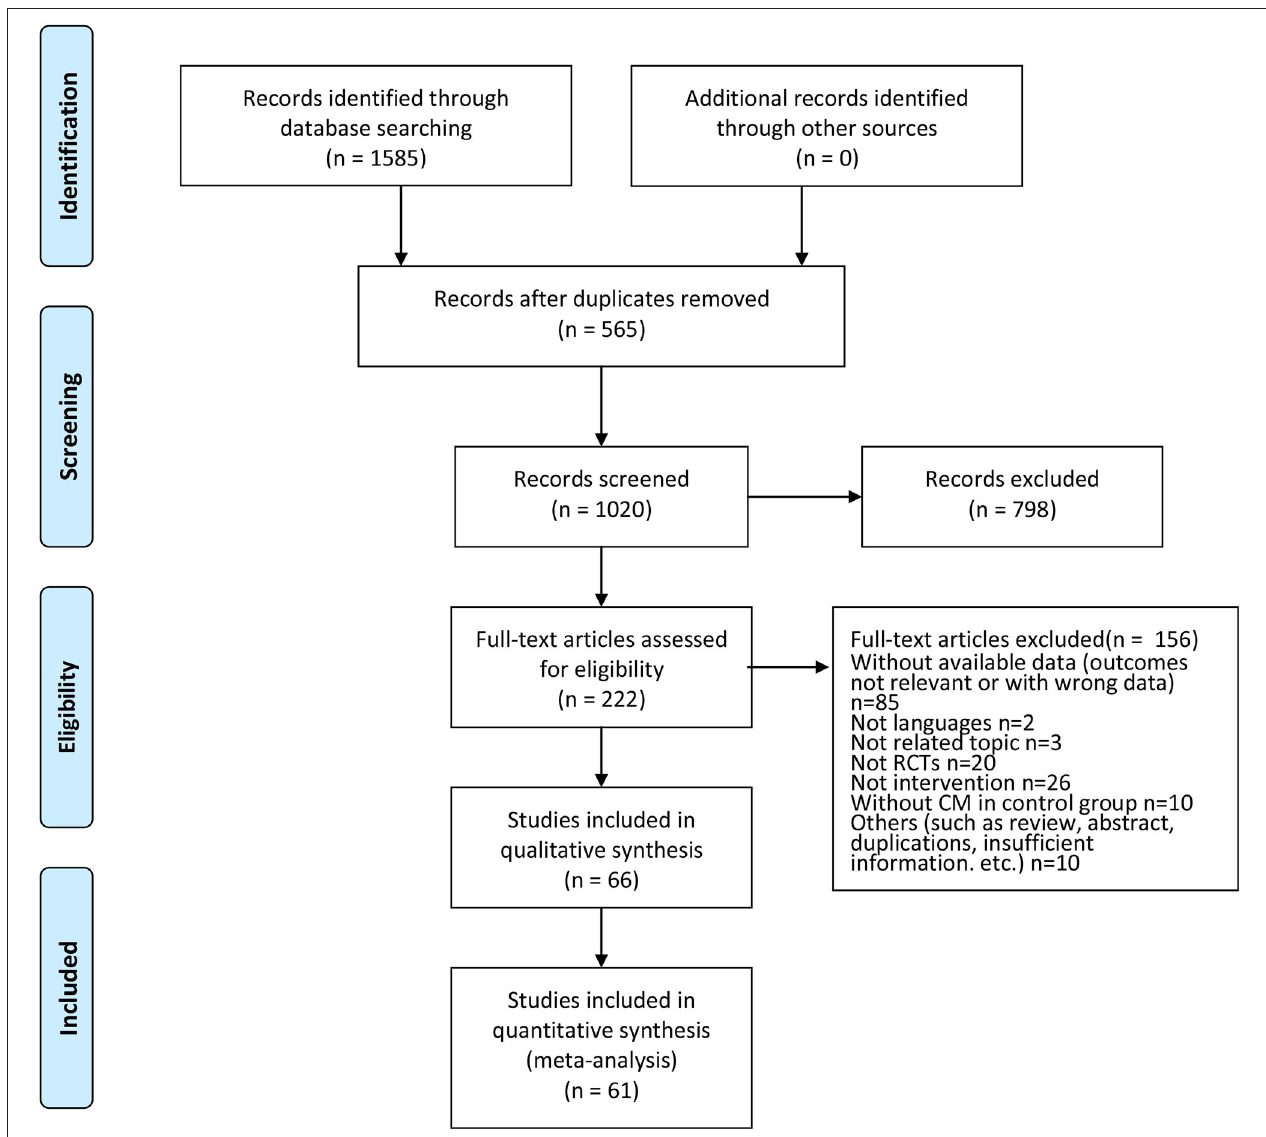
FIGURE 1 | Flow of the trial selection